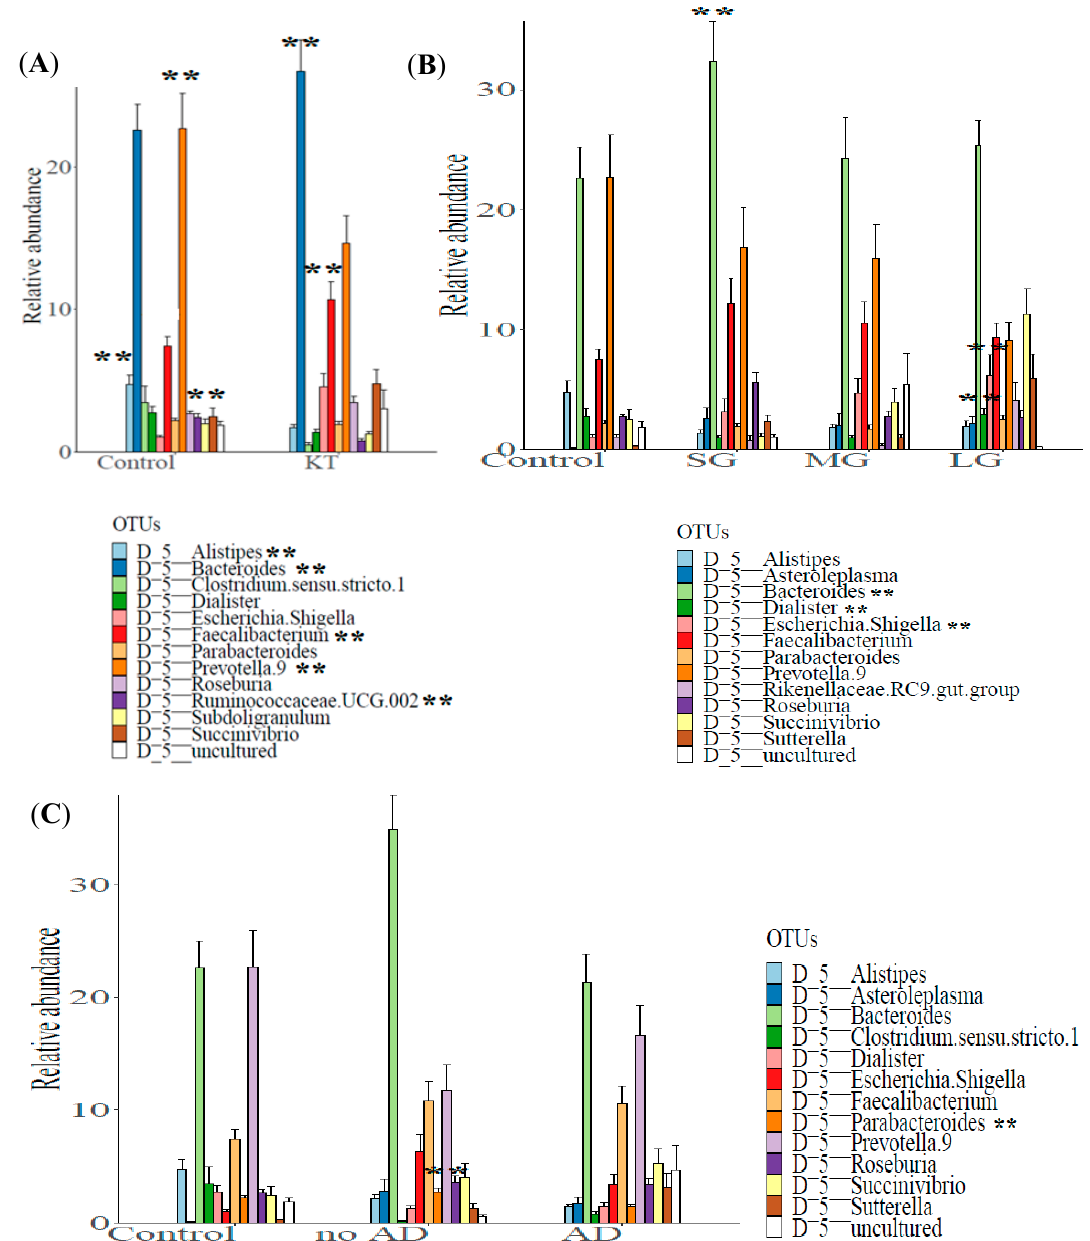
Figure 3. Comparison of the mean relative abundance of bacterial operational taxonomic units (OTUs) at genus (taxonomic level L6) between ( A ) control group (n = 18) vs. kidney transplant recipients (n = 40), ( B ) control subjects and patients after short (n = 11), medium (n = 20), and long post graft-period (n = 9), and ( C ) control subjects; patients suffering and non-suffering from associated diseases (n = 24 and n = 16 respectively). **: high statistical significance.